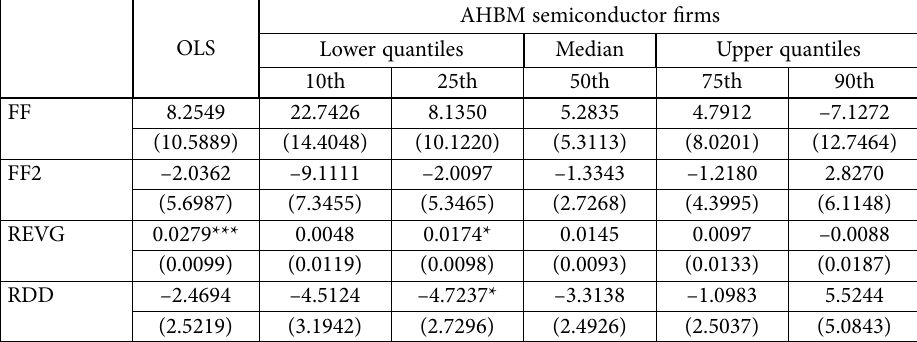
Table 8. OLS and QR results of AHBM and ALBM semiconductor firms AHBM semiconductor OLS